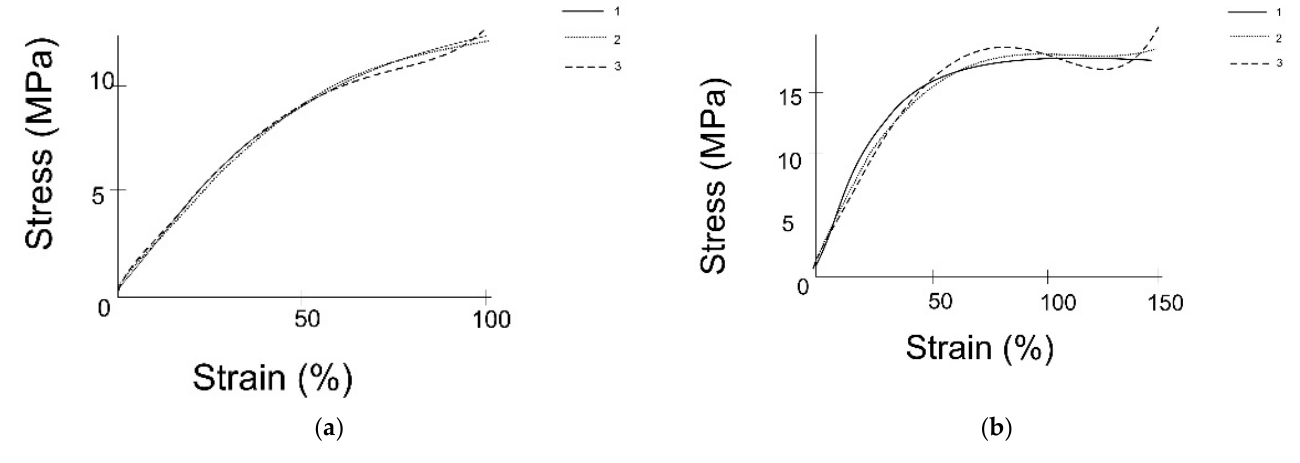
Table 4. Values of hyperelastic models for two samples.